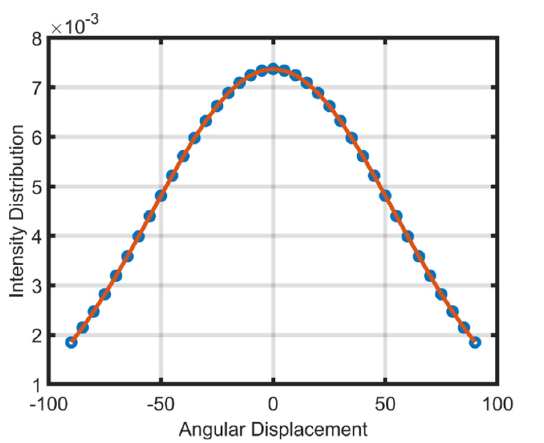
Figure 6. LED light intensity distribution ( 𝜇 = 0, 𝜎 = 54.1218).